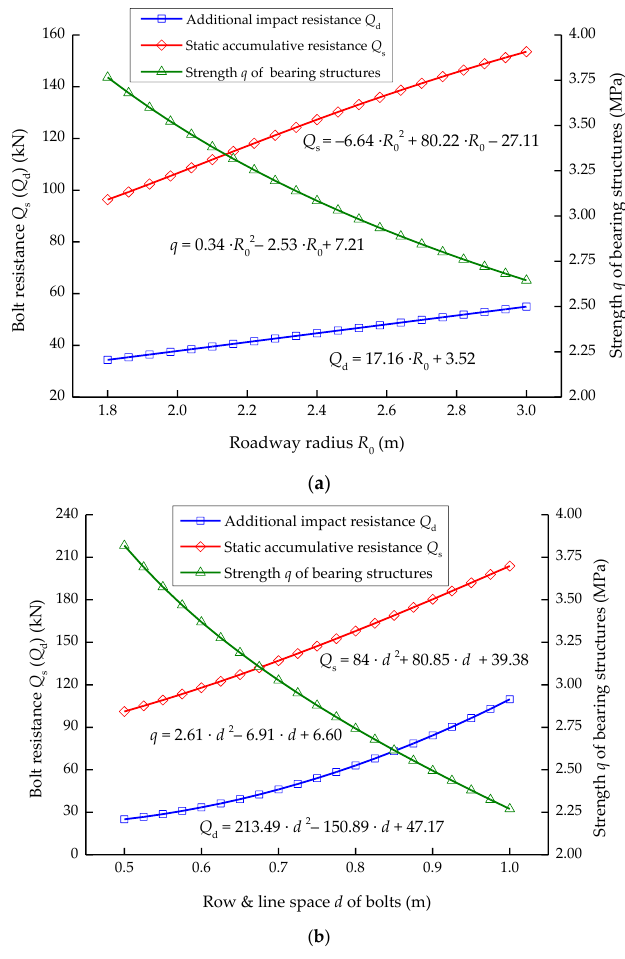
Figure 16. Influences of parameters of roadway supports on loading of bolt supports: (a) Roadway radius R 0 ; (b) Row and line space d of bolts.